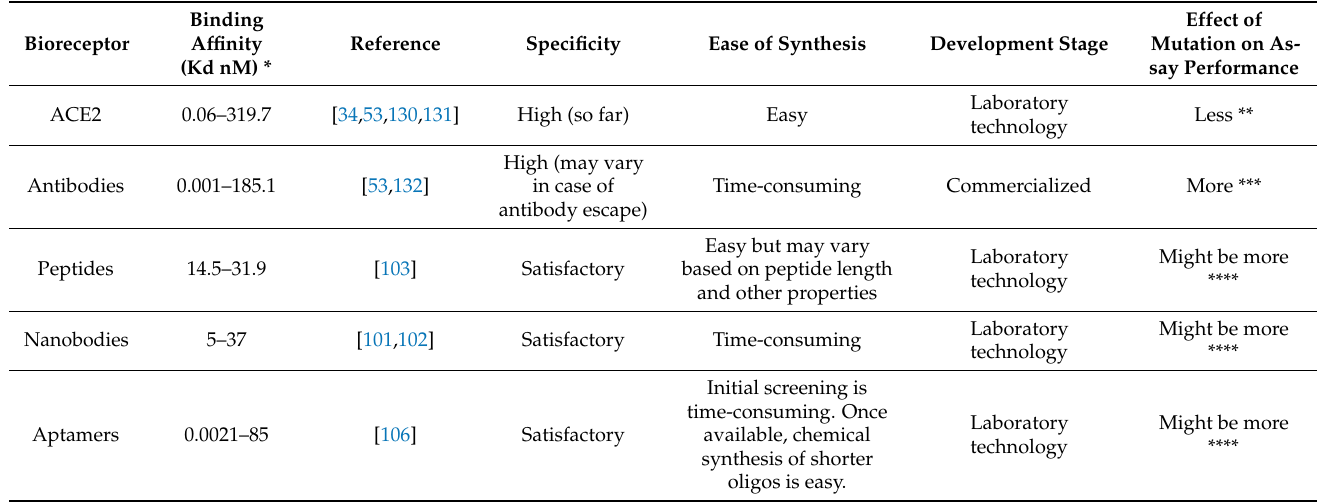
Table 3. Comparison between ACE2 and other related